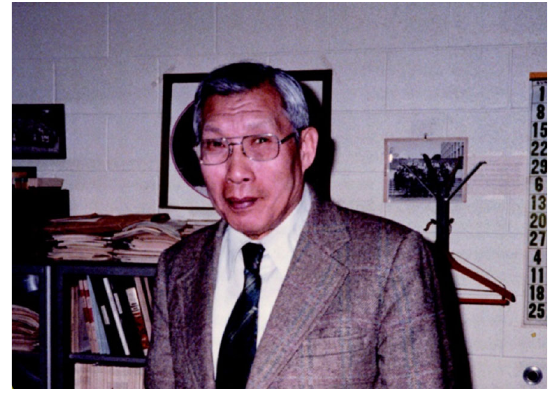
Figure 2. C. C. Li on the occasion of his seventieth birthday in